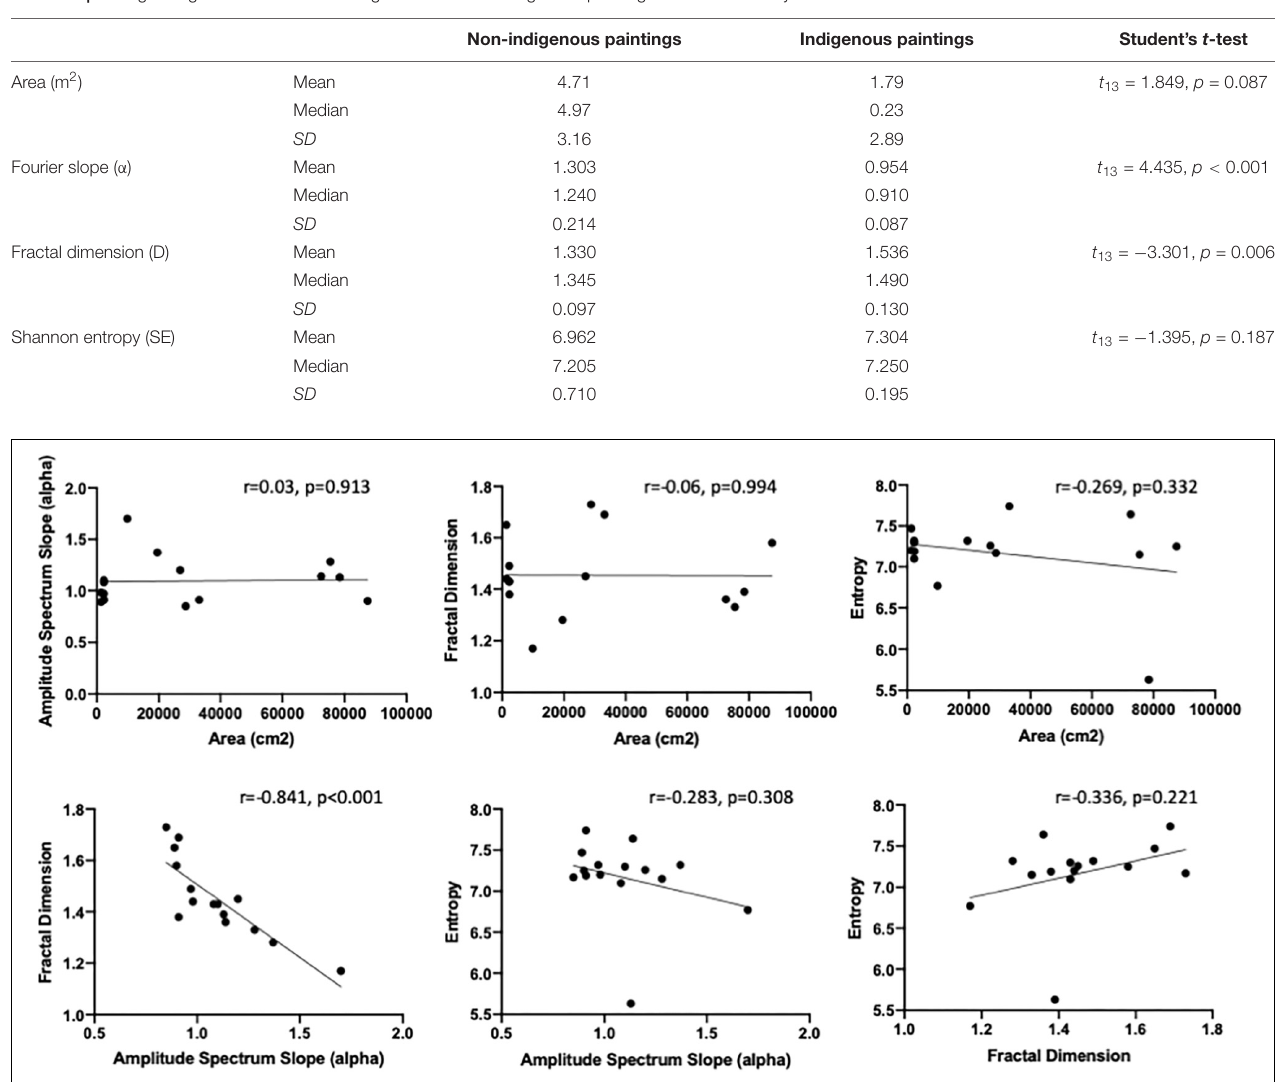
TABLE 4 | Average image characteristics of Indigenous and non-Indigenous paintings used in this study.